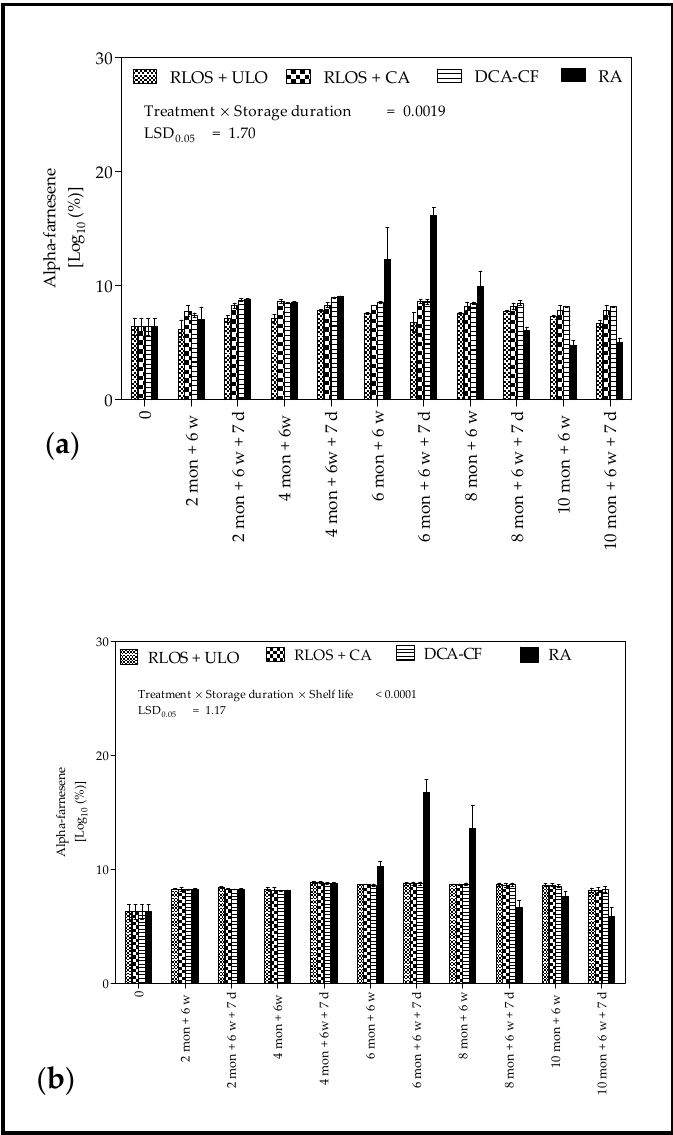
Figure 7. Alpha-farnesene (Log% peak area) of ‘Granny Smith’ apples harvested in the 2015 ( a ) and 2016 ( b ) seasons at commercial maturity and stored for up to 10 months at 0 °C in various storage conditions, evaluated every two months followed by a 6 week simulated shipment and handling period, and at 7 days on the shelf (20 °C and 65% RH). Vertical bars represent the standard error (SE) of mean values of 3 replicates (1 replicate = 10 fruit). LSD 0.05 represents least significant difference ( p < 0.05). LSD 0.05 represent least significant difference ( p < 0.05). For storage dura- tion, mon—months; w—week; and d—days. RLOS—repeated low oxygen stress; ULO—ultra-low oxygen; CA—controlled atmosphere; DCA-CF—dynamic controlled atmosphere-chlorophyll fluo- rescence; RA—regular atmosphere.